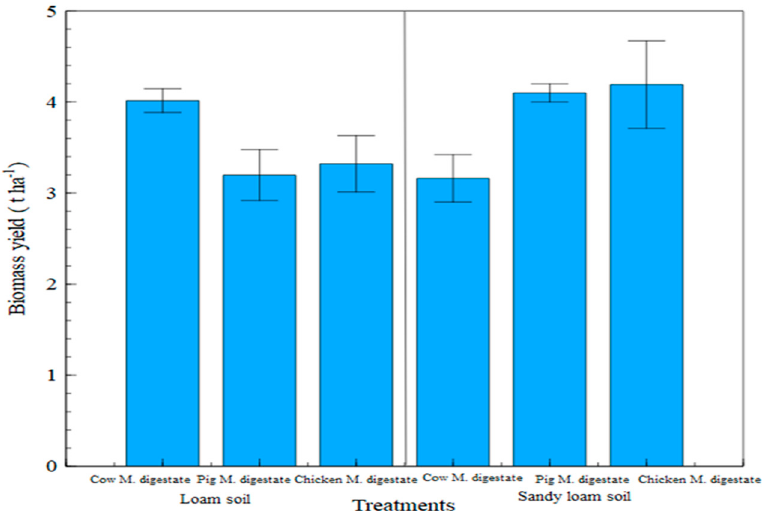
Figure 11. Biomass yield measurement in digestate treatments between soil types. Factor A (soil type) = *; Factor B (fertilizer) = n.s. A × B = *; * denotes significant differences at p < 0.05.